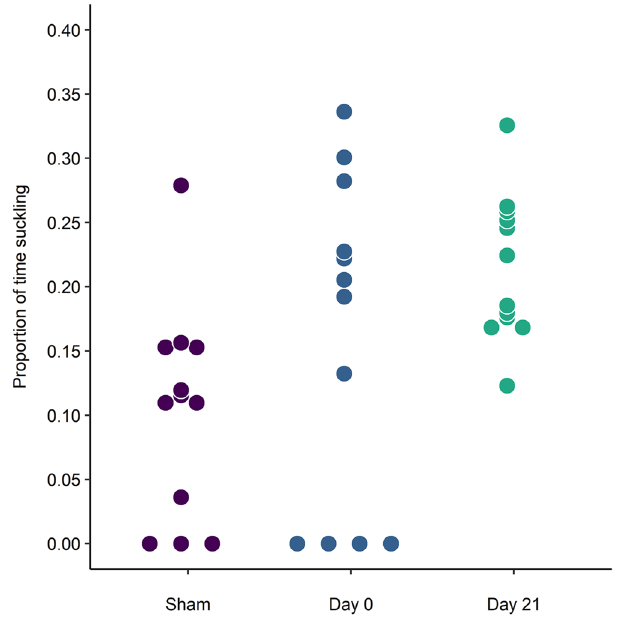
Figure 2. Scatterplot showing the proportion of time spent suckling from a milk bottle in calves disbudded the morning of (Day 0) or 21 d before (Day 21) the startle test, or sham-disbudded (Sham, n = 12/treatment). The startle test consisted of a 10-min period in which a sudden noise was emitted as soon as the calf approached the milk bottle. Each dot represents an individual